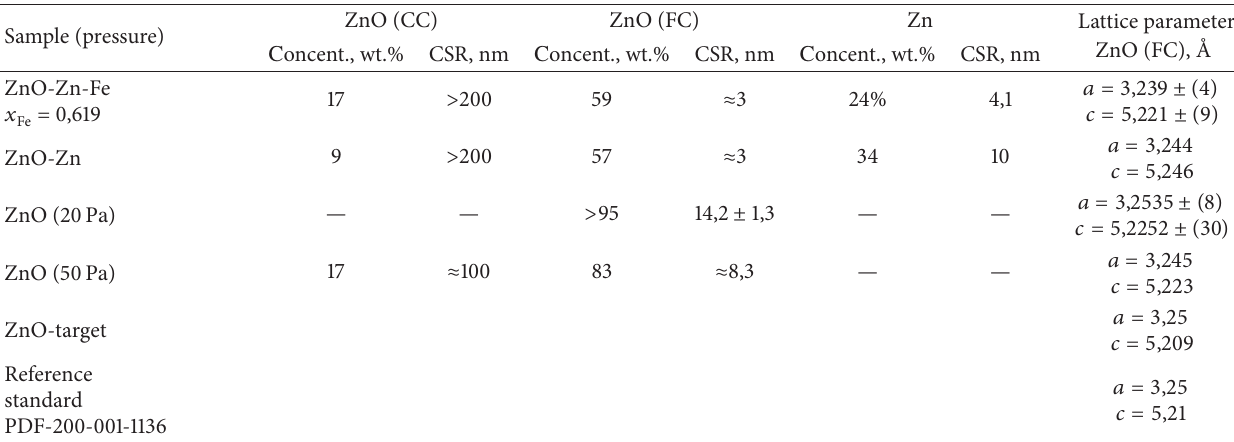
Table 2: Relative concentrations of the crystalline phases, average values of coherent scattering regions (CSR) in NPs, and lattice parameters of crystalline phases